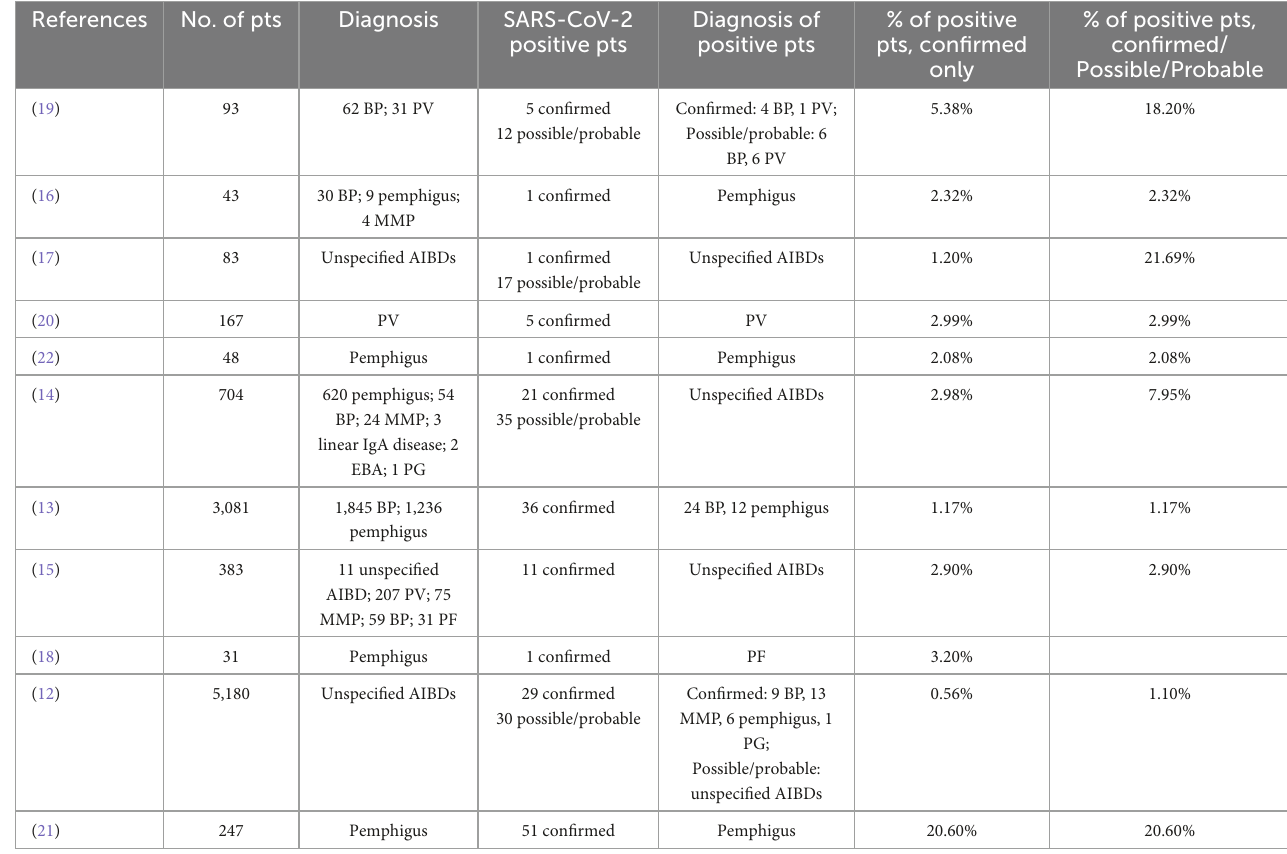
TABLE 1 Summary of relevant published studies reporting prevalence data on SARS-CoV-2 infection in AIBDs